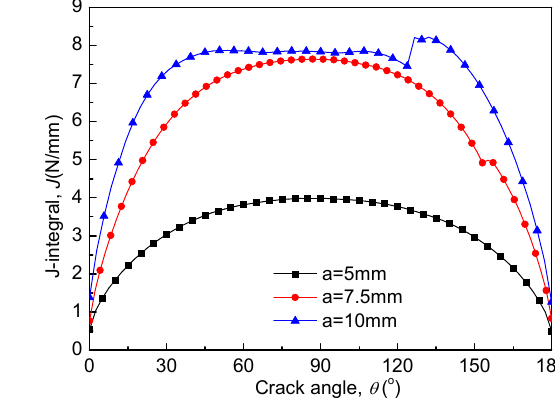
Figure 11: J -integral ahead of crack